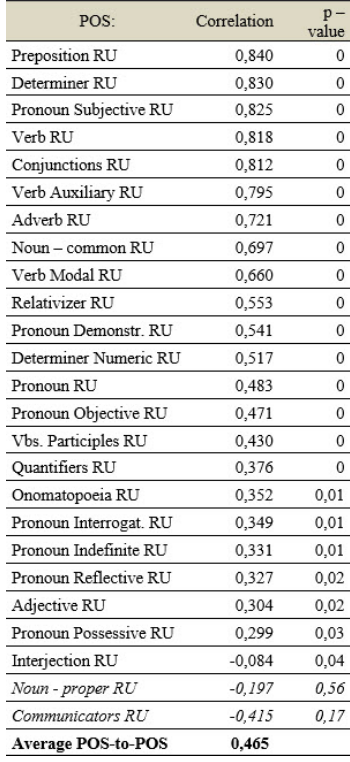
Table 1. Between-languages correla- tions for the development over the time of lan- guage acquisition of POS RU